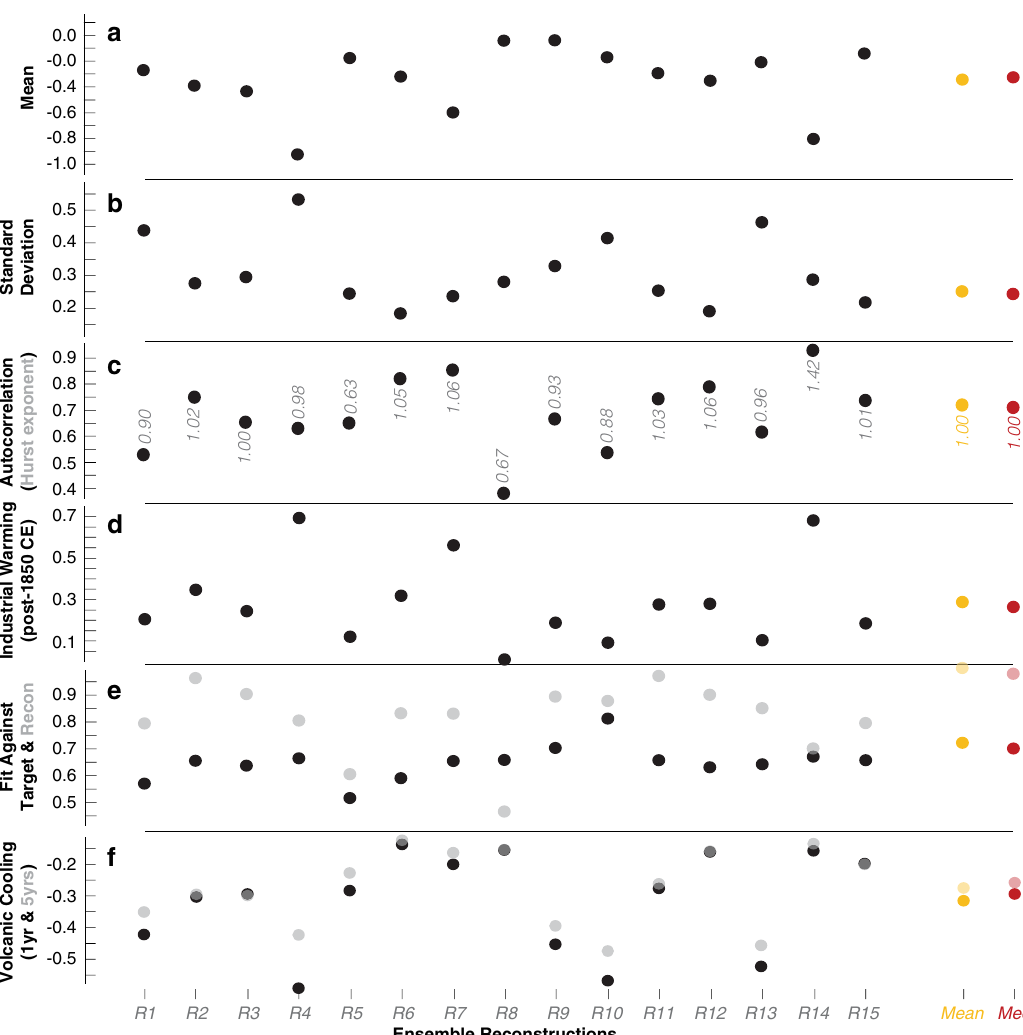
Fig. 5 Reconstruction characteristics. a – d Mean, standard deviation, fi rst-order autocorrelation (and highest Hurst exponent H ), and the difference between industrial and pre-industrial temperature means (after and before 1850 CE) of the 15 ensemble reconstructions (R1 – R15), as well as their mean and median (orange and red). e Correlation coef fi cients of the 15 ensemble reconstructions against the gridded instrumental target mean (Target Fit; black) and against the reconstruction mean (Recon Fit; opaque). f One (black) and 5-year (opaque) post-volcanic cooling relative to the 10 pre-eruption years (see Supplementary Fig. 3 for the 24 eruption years used). All statistics refer to 72 – 2000 (or 1794 – 2000 CE when considering the mean of the instrumental Ensemble reconstructions . In the fi rst step of data screening, nine groups did not Quebec and Labrador (QUL; spruce), northern Scandinavia (NSC; pine), and northern Siberia (YAM, TAI and NYA; larch) are from the northern boreal remove any of the raw TRW measurement series (R1 – R3, R6 and R7, R9 and forest. The number of TRW samples from each collection, either in the form of R12 – R14). R4 removed all TRW series that correlate at r < 0.2 with the site master increment cores or stem discs, ranges from 224 (SCO) to 2725 (QUL). Each chronology, R5 removed all TRW series <40 years, R8 removed all TRW series regional TRW dataset has been updated into the 21st century (Fig. 1). The majority of TRW measurements was derived from remnant snags and subfossil wood remains (i.e., there is a much larger proportion of samples from relict materials versus living trees). The annual cross-dating precision of all TRW measurements within each collection has been independently con fi rmed by the RCS) 49 for TRW detrending (R2 – R6, R11 and R14). R7 and R13 used traditional detection of cosmogenic radiocarbon events in 774 and 993 CE, i.e., abrupt RCS detrending 18 , R1 developed an ensemble of 16 different RCS chronologies per changes in the Earth ’ s atmospheric radiocarbon ( 14 C) abundance 6 . For each of the nine regional TRW datasets, neither the number of TRW series nor the mean segment length and the mean series age is stable over time 3 . The 15 independent detrending 16 , R10 used cubic smoothing splines with 50% frequency cut-off at 2/3 participating groups all based their reconstruction on a combination of these of the individual TRW series length, R12 used age band decomposition for nine regional TRW datasets, but each used a slightly different gridded instru- detrending (ABD) 17 , and R15 detrended all TRW series with non-signi fi cant negative slopes by subtracting their mean and applied SF RCS on the remaining mental temperature dataset as a reconstruction target. These targets include four data. Based on site-speci fi c temperature signals, nine groups included all nine TRW seasonal windows of 2, 3 and 5 months between May and October (Fig. 2). The chronologies in their fi nal large-scale reconstruction (R2 and R3, R5 and R8 – R13). start and end dates of the 15 target datasets vary between 1750 and 1901 CE and R1 and R6 excluded data from the western United States and used seven chron- 2000 and 2016 CE, respectively. Restricted to the NH, nine latitudinal bands ologies (QUL, NSC, ALP, YAM, TAI, ALT, NAY), R4 and R15 excluded two sites between the equator and the pole, as well as four regional means were selected as from central and eastern Siberia used another combination of seven chronologies spatial target domains. The 15 groups extracted data from various versions of the (GTB, SCO, QUL, NSC, ALP, YAM, ALT), and R7 only considered information gridded Berkeley 42 , CRU 43 – 47 and HadCRU 48 products (see Fig. 2 and Supple- from fi ve TRW chronologies in their fi nal reconstruction (GTB, NSC, ALP, YAM, mentary Table 1 for an overview).